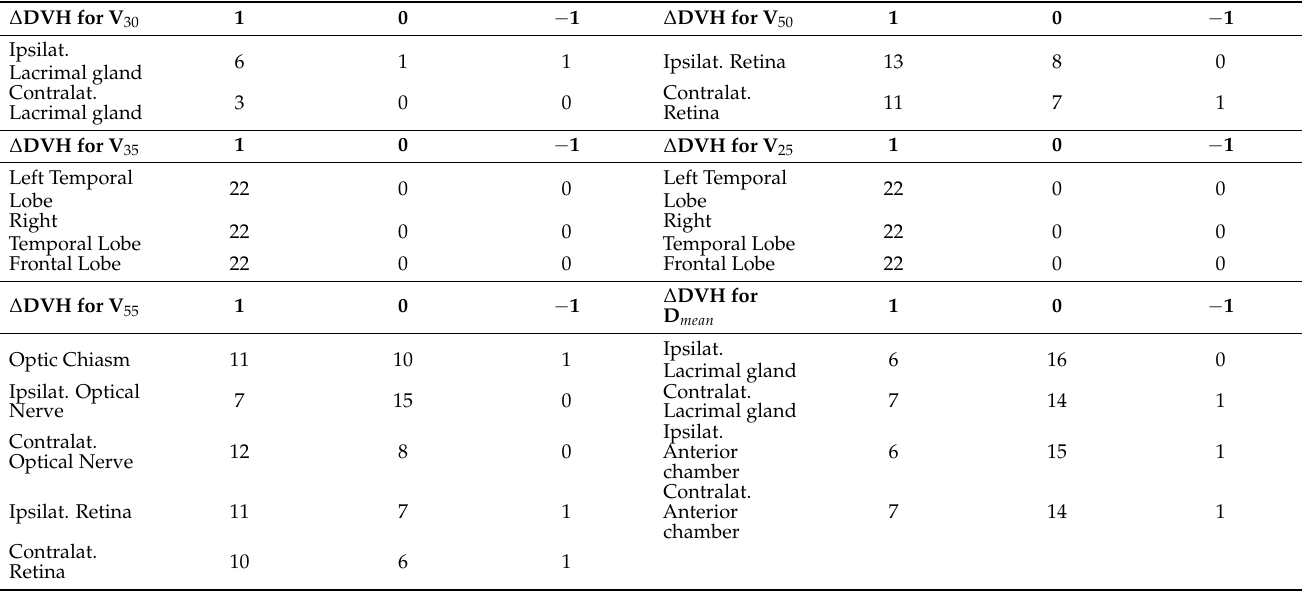
Table 4. Dosimetric analysis for OARs. Each cell contains the number of patient cases as a function of ∆ DVH values: ∆ DVH = +1 when IMPT performs better than VMAT, ∆ DVH = − 1 if VMAT performs better than IMPT and ∆ DVH = 0 when no net benefit was found in either the two techniques.